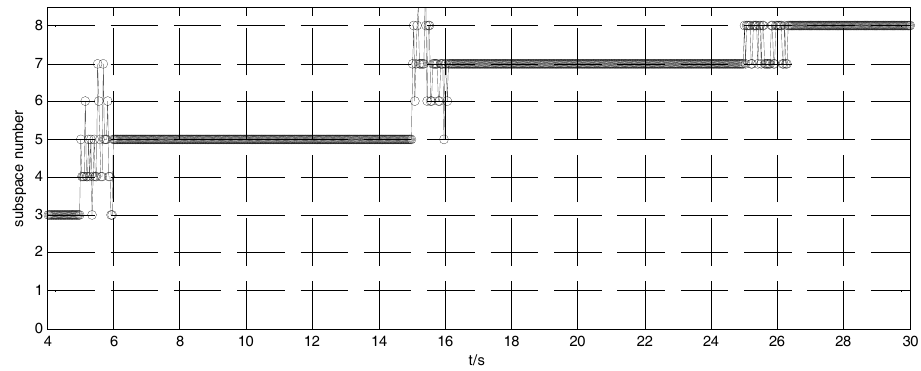
Figure 13. Output trajectory of the CART in the case of multiple wind farms.